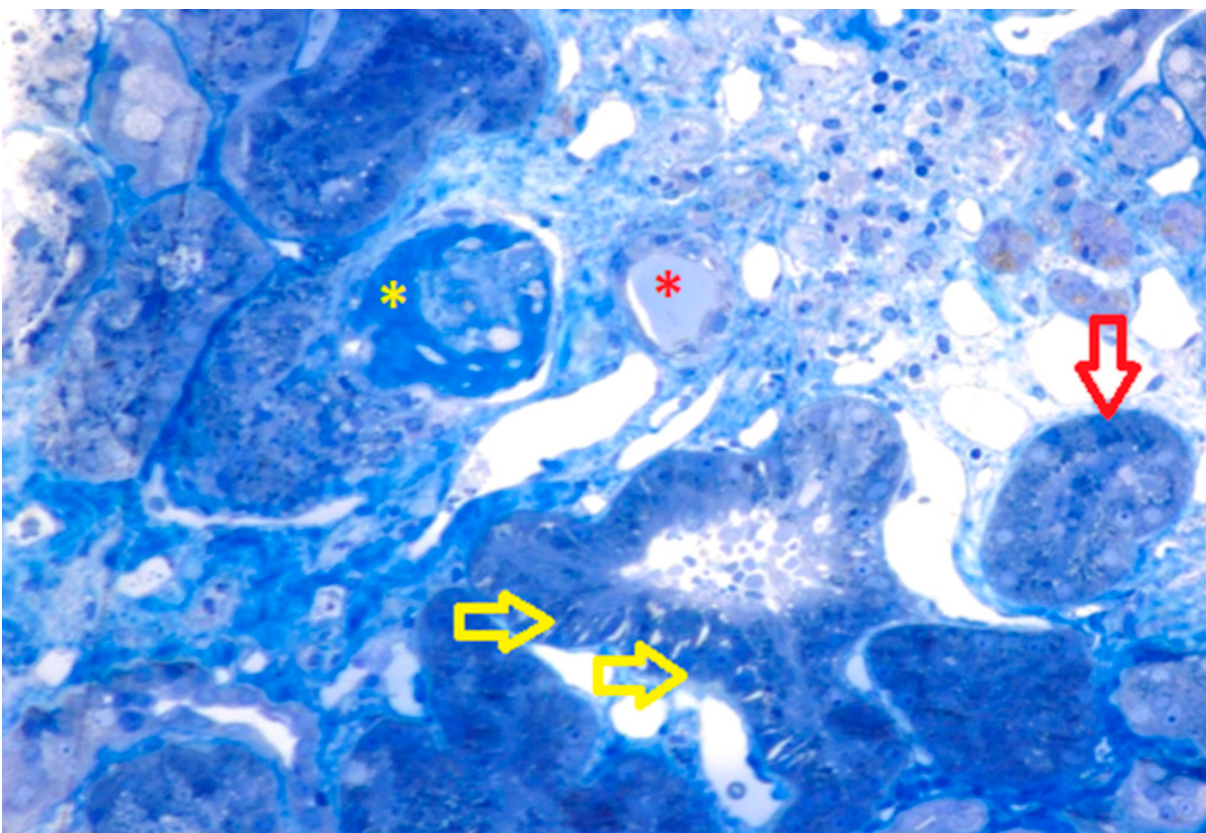
Figure 1. Light microscopy. Global glomerulosclerosis (yellow asterisk); tubular epithelium with cellular edema and vacuolization (yellow arrows); a tubular lumen with amorphous, acellular material inside (red asterisk); and a tubule with edematous epithelium and complete luminal obstruction by fibrosis and cellular fragments. In the upper right corner, minimal inflammation can be noticed, highlighted by the presence of dark blue neutrophils. In the lower left corner, the bright blue pattern of the interstitium suggests fibrosis (toluidine blue, 40× magnification).